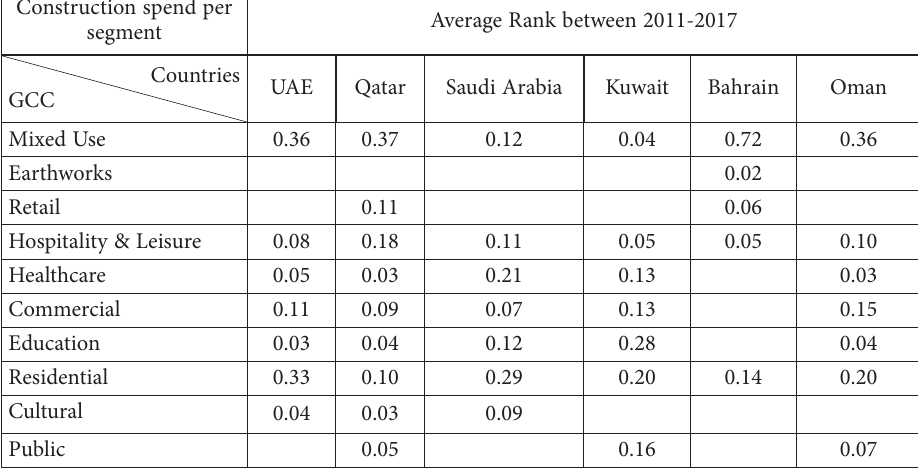
Average Rank between